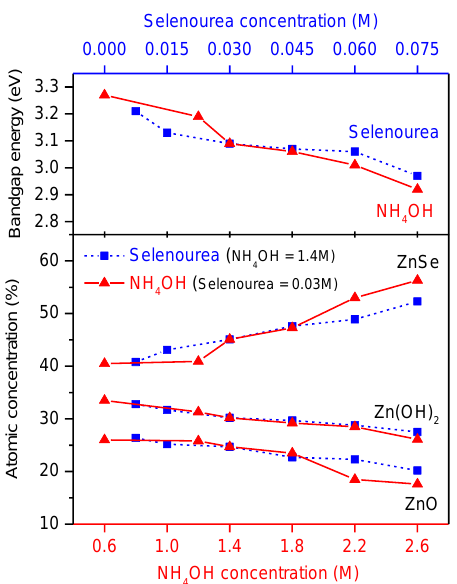
Figure 14. Bandgap energies and atomic percentages of ZnSe, Zn(OH) 2 , and ZnO of Zn(Se,OH) films as a function of selenourea concentrations and ammonia concentrations.